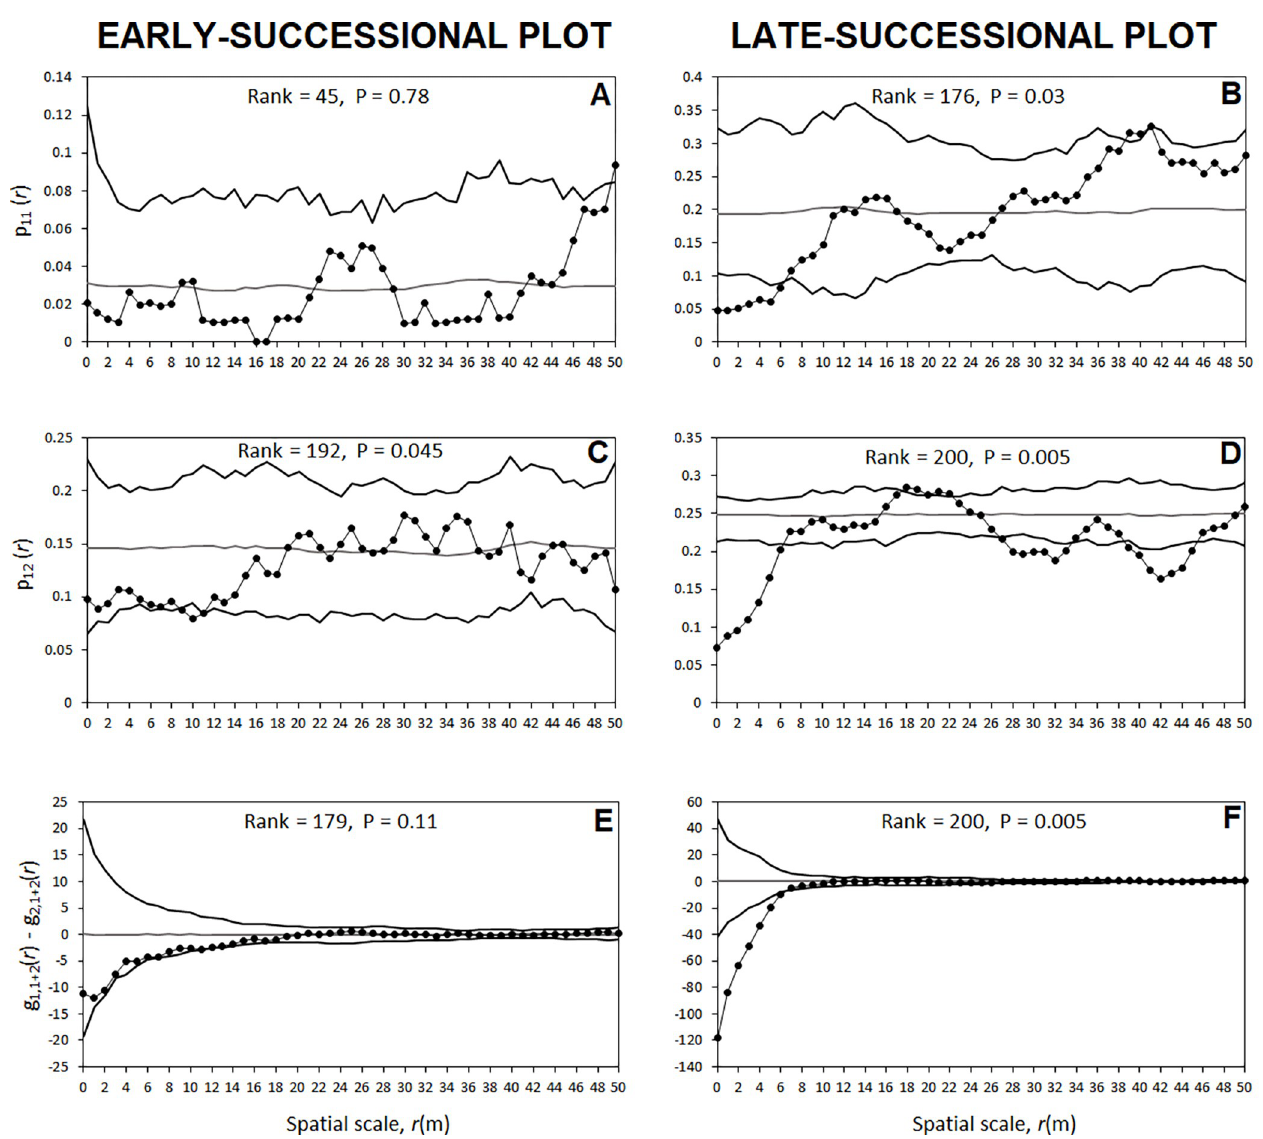
Fig 5. Analysis of C . humilis with feces in the two study plots (the early and late-successional plots) areas using mark connection functions as summary statistics. (A, B) The mark connection function p 11 ( r ) gives the conditional probability that, from two C . humilis that are separated by distance r , both are type 1 (i.e., with feces). (C, D) The mark connection function p 12 ( r ) gives the conditional probability that, from two C . humilis that are separated by distance r , the first is type 1 (i.e., with feces) and the second is type 2 (i.e., without feces). (E, F) The test statistic g 1,1+2 ( r )—g 2,1+2 ( r ) compares the density of C . humilis (i.e., 1 +2) around C . humilis with feces (i.e., type 1) with the density of C . humilis (i.e., 1+ 2) around C . humilis without feces (i.e., type 2). The expected mark connection function statistics (gray line) and the corresponding simulation envelopes (black lines), being the fifth lowest and highest values of the functions created by 199 simulations under random labelling, are also